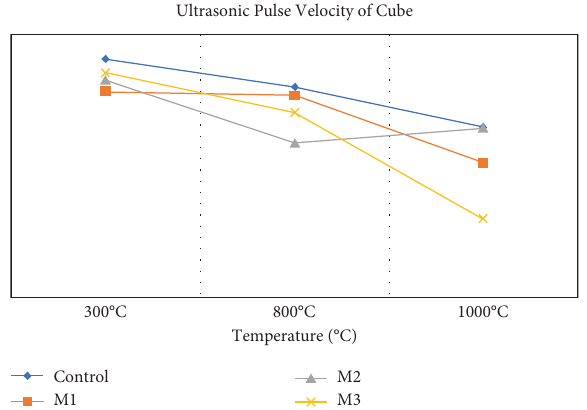
Figure 10: Ultrasonic pulse velocity of concrete samples at varying